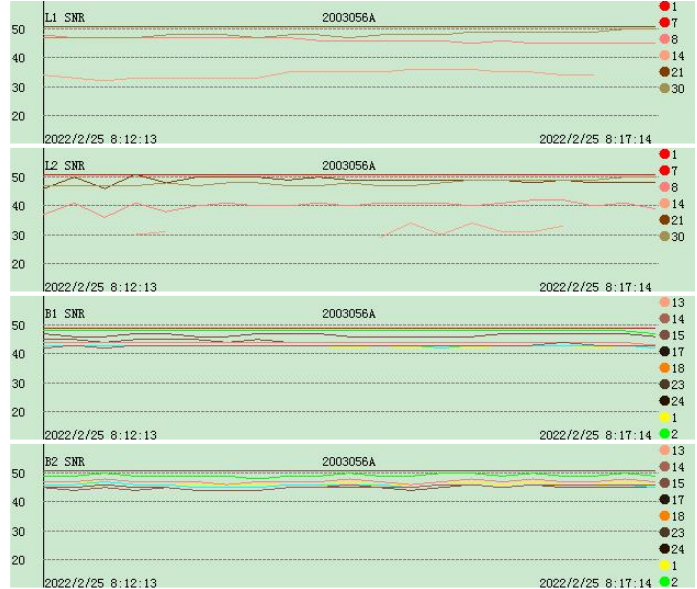
Figure 8. Interactive interface of the visual quality inspection software.